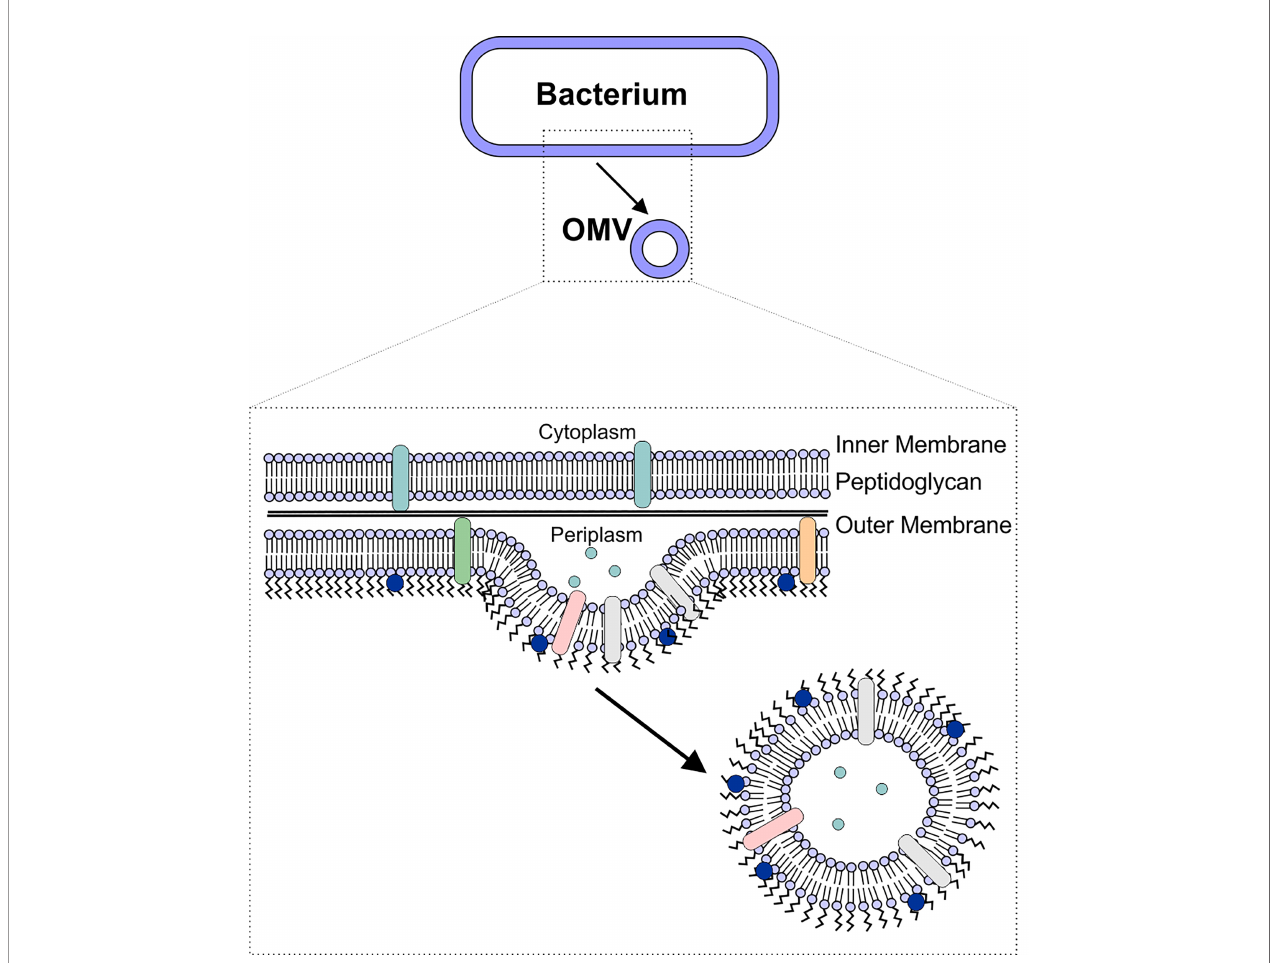
FIGURE 1 | OMV Biogenesis. OMVs are formed due to blebbing of the bacterial outer membrane. The vesicle contains outer membrane-associated proteins and lipids (including lipopolysaccharide), as well as periplasmic components such as